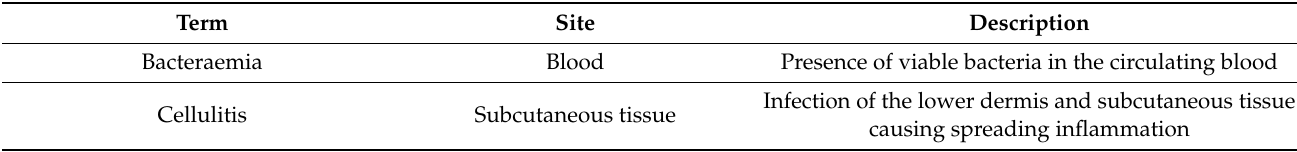
Table 3. Infections with known lymphatic involvement or potential as a lymphatic